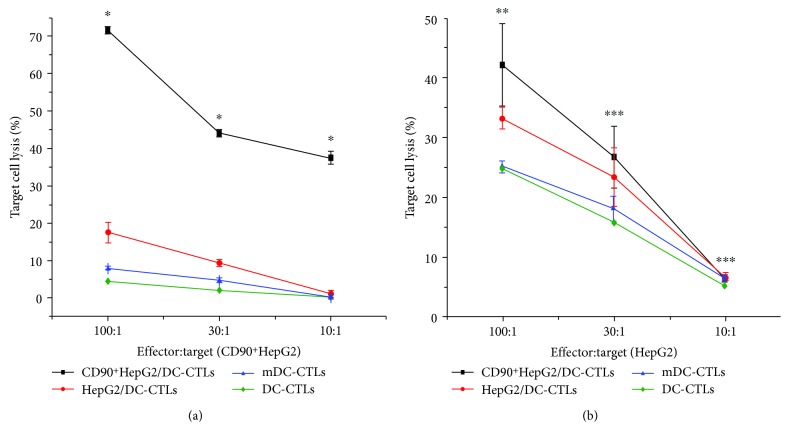
CD90+HepG2/DC-CTLs have more cytotoxicity effect on CD90+HepG2 cells. (a) Lytic activity specific to various CTLs against CD90+HepG2 cells. (b) Lytic activity specific to various CTLs against HepG2 cells. ∗P < 0.001, ∗∗P < 0.05, ∗∗∗P > 0.05.